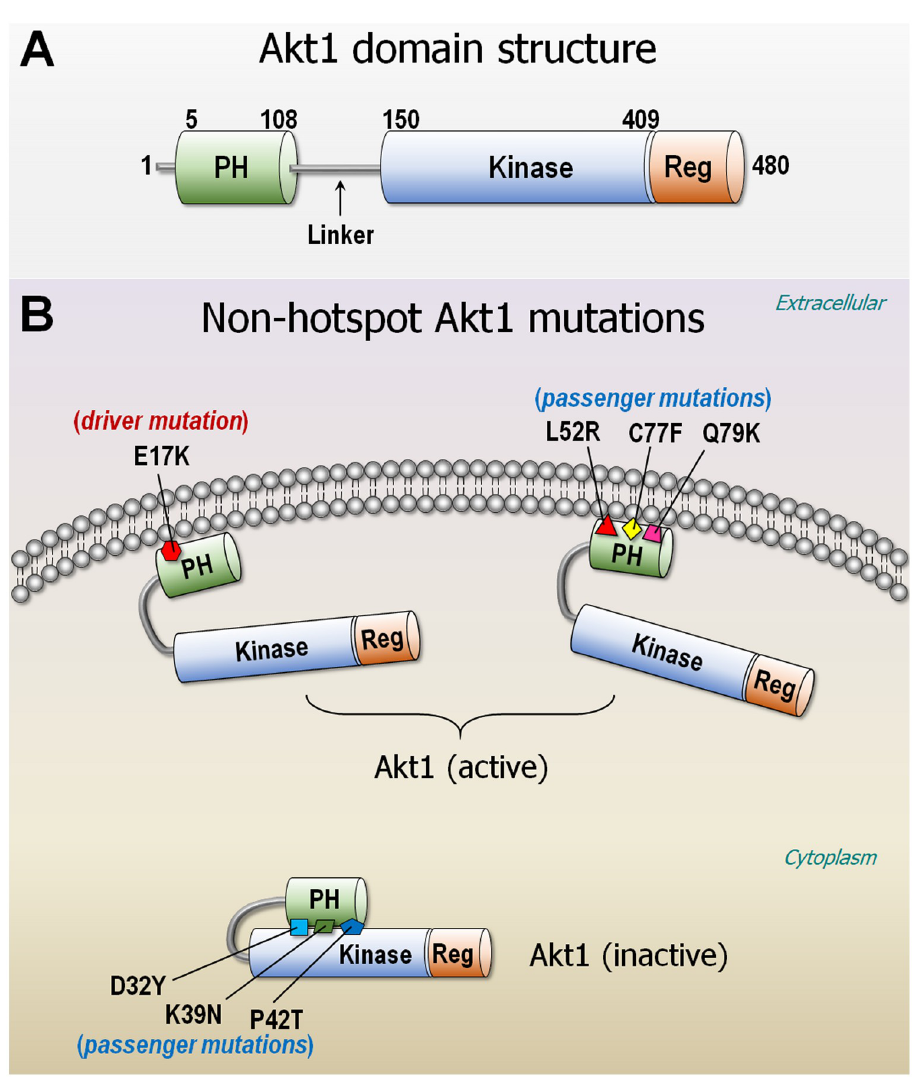
Fig 9. Akt1 domain structure. (A) Akt1 is composed of PH (residues 5–108), kinase domain (residues 150–408), and regulatory domain (residues 409–480). The linker connects the PH and kinase domains. (B) Nonhotspot, passenger mutations can be functional as the driver mutation E17K. The PH domain mutants, L52R, C77F, and Q79K activate Akt1 as the E17K driver does, whereas D32Y, K39N, and P42T mutants at the interface between the PH and kinase domains reduce Akt1 in the inactive conformation. PH, pleckstrin